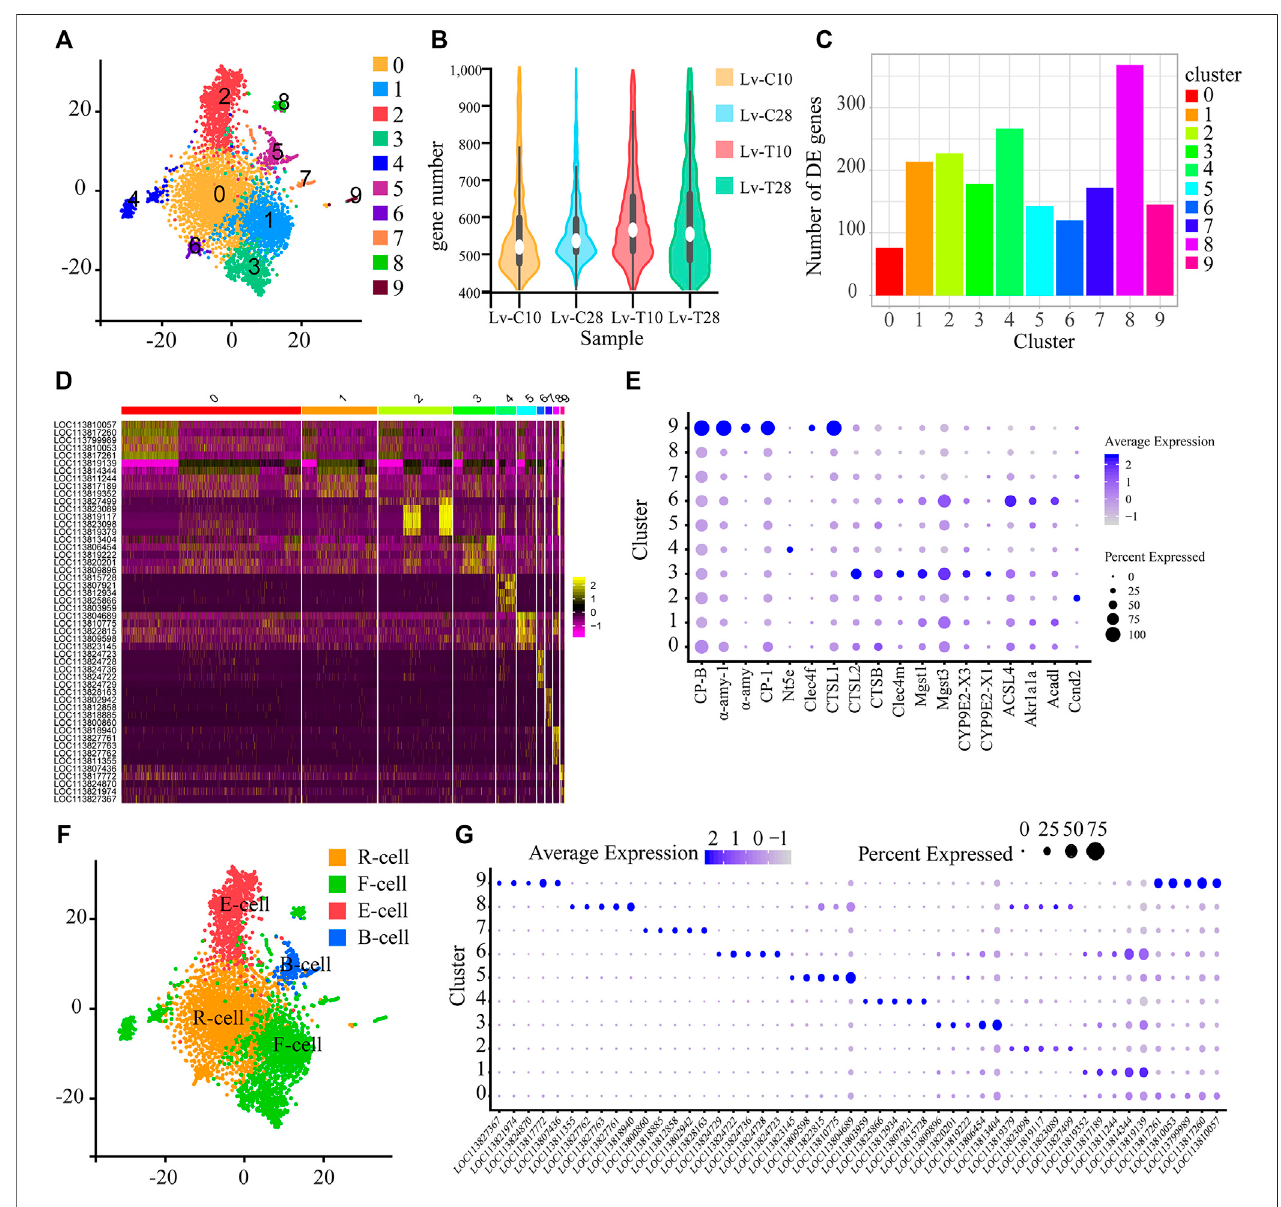
FIGURE1| Single-cellsequencingrevealsthesubtypesofshrimphepatopancreaticcells. (A) t-SNEvisualizationshowingthe10single-cellclustersidenti fi edinthe 5185 hepatopancreas cells. Each dot represents a single cell; clusters are distinguished by color. (B) The number of genes per cell in each of the four treatments. (C) Histogram showing the number of genes upregulated in the cold (experimental) treatment group as compared to the control group in each of the single-cell subgroups shown in panel (A) . (D) Heat map showing the expression patterns of the fi ve most strongly upregulated genes in each cell cluster. Each column represents a cell, and each rowrepresentsagene.Brighter yellowcellsaremore upregulated; brighterpinkcells aremoredownregulated. (E) Bubble chartshowingtheexpression levels of candidate molecular marker genes across all cell subgroups. The size of the bubble represents the ratio of the total expression of each marker gene in the corresponding cluster to its total expression across all clusters. That is, larger bubbles indicate genes that were relatively frequently expressed in the corresponding cluster, while darker bubbles indicate genes that were relatively highly expressed in the corresponding cluster. (F) t-SNE visualization showing the cell clusters classi fi ed into the four major types of hepatopancreas cells: resorptive cells (R-cells; orange), blister-like cells (B-cells; blue), fi brillar cells (F-cells; green), and embryonic cells (E-cells;red).Cellclusterswereclassi fi edascelltypesbasedonthemolecularmarkersandKEGGsignalingpathways. (G) Bubblechartshowingtheexpressionlevelsof candidatemolecularmarkergenesacrossallcellsubgroups.Thesizeofthebubblerepresentstheratioofthetotalexpressionofeachmarkergeneinthecorresponding clustertoitstotalexpressionacrossallclusters.Thatis,largerbubblesindicategenesthatwererelatively frequentlyexpressedinthecorrespondingcluster,whiledarker bubbles indicate genes that were relatively highly expressed in the corresponding